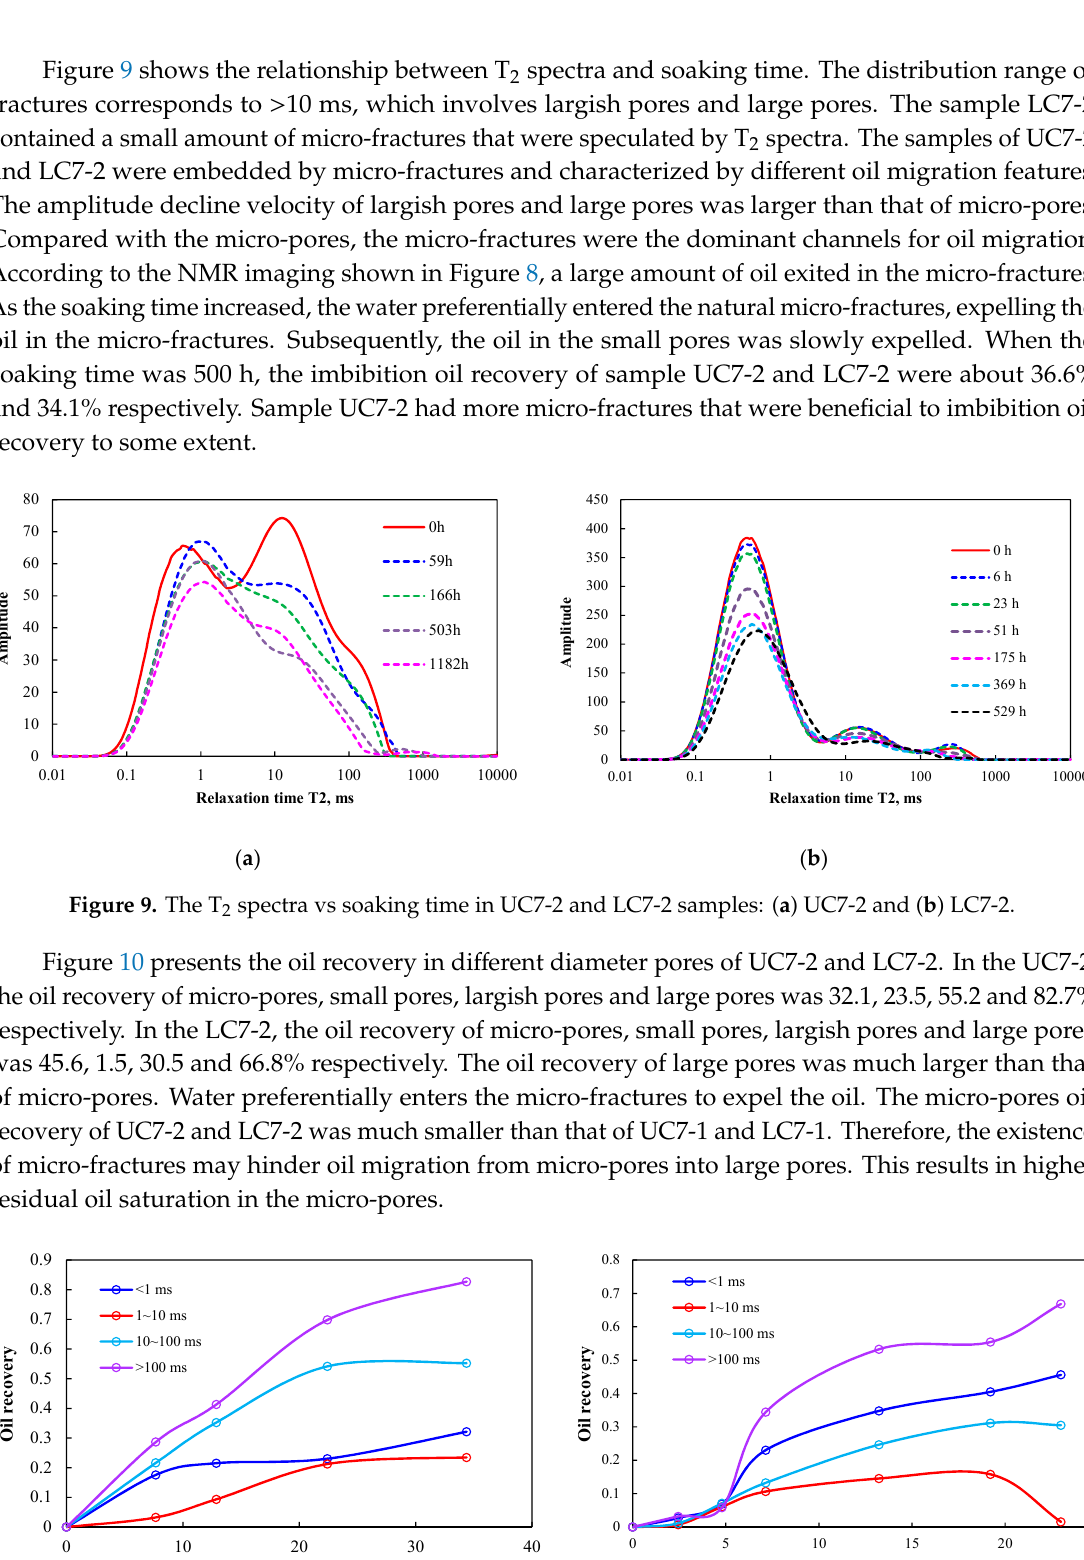
Figure 8. NMR imaging: ( a ) 0 h and ( b ) 59 h. The color bar can reflect oil saturation. 208